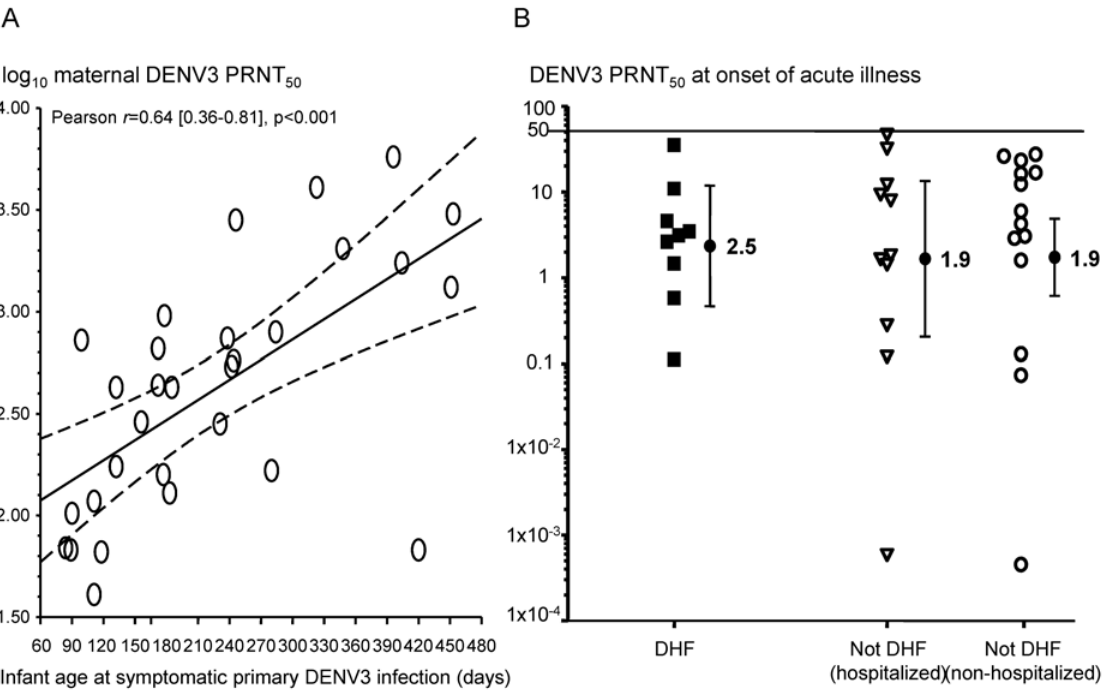
Figure 4. Estimated DENV3 neutralizing capacities at birth and illness onset in infants with symptomatic primary DENV3 infections. (A) Log 10 transformed PRNT 50 to DENV3 in maternal plasma (estimate for birth time point) were positively correlated with infant age at onset of symptomatic primary DENV3 infection ( n =30). Mean (95% CI) of the Pearson correlation coefficient ( r ) is shown. The linear regression curve and 95% CI are shown as a solid line and dashed lines, respectively. (B) Endpoint DENV3 PRNT 50 at the time of symptomatic primary DENV3 infection were extrapolated from pre-illness plasma samples as described in the Results ( n =34). Closed squares, hospitalized infants with DHF; open triangles, hospitalized infants without DHF; open circles, nonhospitalized infants without DHF. The closed circles and error bars are the DENV3 PRNT 50 geometric mean titers (GMT) and 95% CI, respectively. There were no significant differences among the disease severity groups ( p